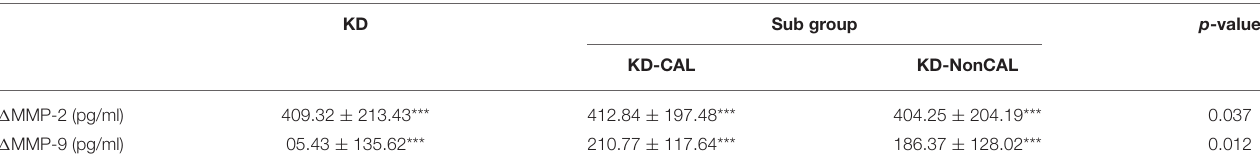
TABLE 4 | Changes of MMP-2, and MMP-9 levels before and after treatment. KD Sub group p -value KD-CAL KD-NonCAL